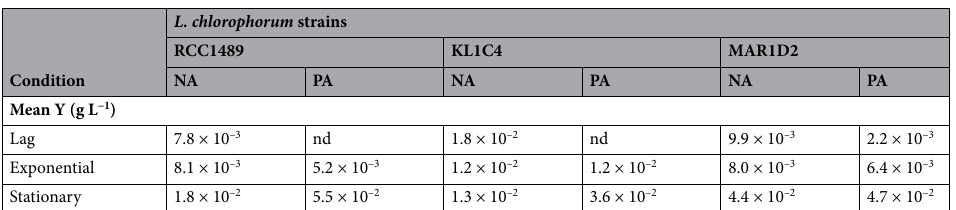
Table 1. SEP yields (Y; g L −1 ) from culture supernatants for the three L. chlorophorum strains during the different growth phases under non-axenic (NA) and pseudo-axenic (PA) conditions. nd not determined because values were overestimated due to the presence of salts.